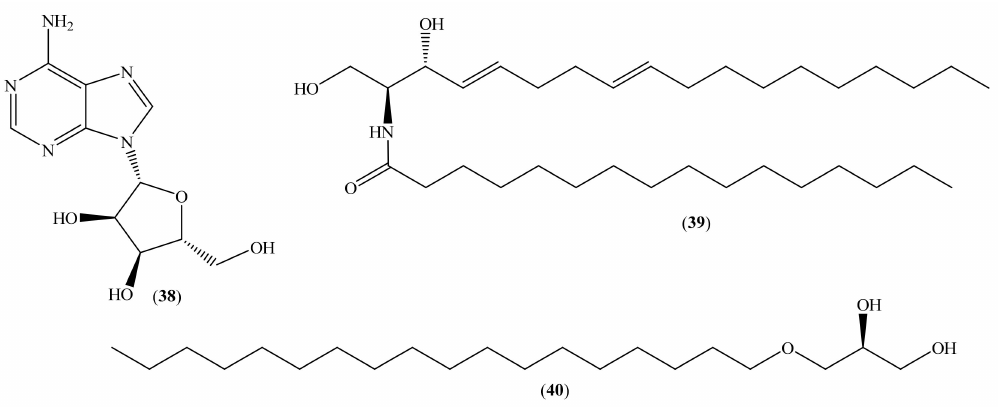
Figure 5. Chemical structure of compounds ( 38 – 40